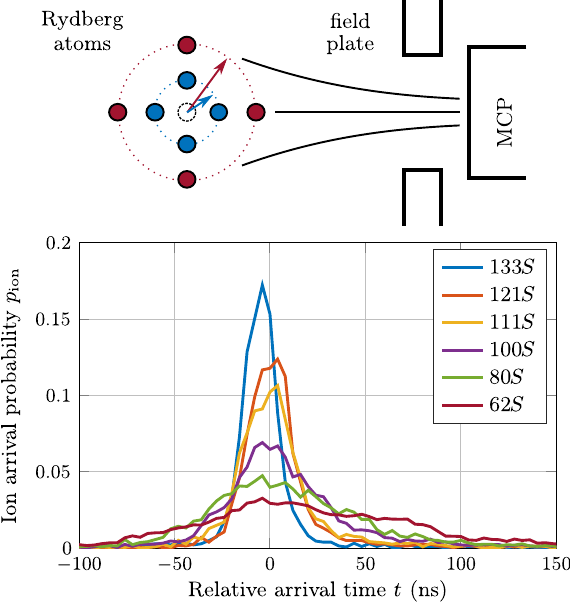
FIG. 10. Ion arrival time spread due to the l -changing collision. The top panel schematically shows the positions of the Rydberg atoms at the moment of the ionization. The Rydberg atoms are located on a sphere with the radius r ð E Þ , which depends on the released energy E . The bottom panel shows the relative ion arrival time of the ionized Rydberg atoms, which went through an l -changing collision. The highest principal quantum number (dark blue) shows the lowest spread, which means that the energy release during the collision was low. The lowest principal quantum number (dark red) shows the widest spread because of the higher energy release during the inelastic collision. All Rydberg atoms are ionized after a 50 - μ s delay time with an electric field of 180 V cm − 1 arrival time is asymmetric. The ion arrival time distribution of Fig. 10 is reconstructed by fitting a linear combination of the ð t Þ to the measured simulated arrival time distributions p r ð t Þ : arrival time distribution p ion